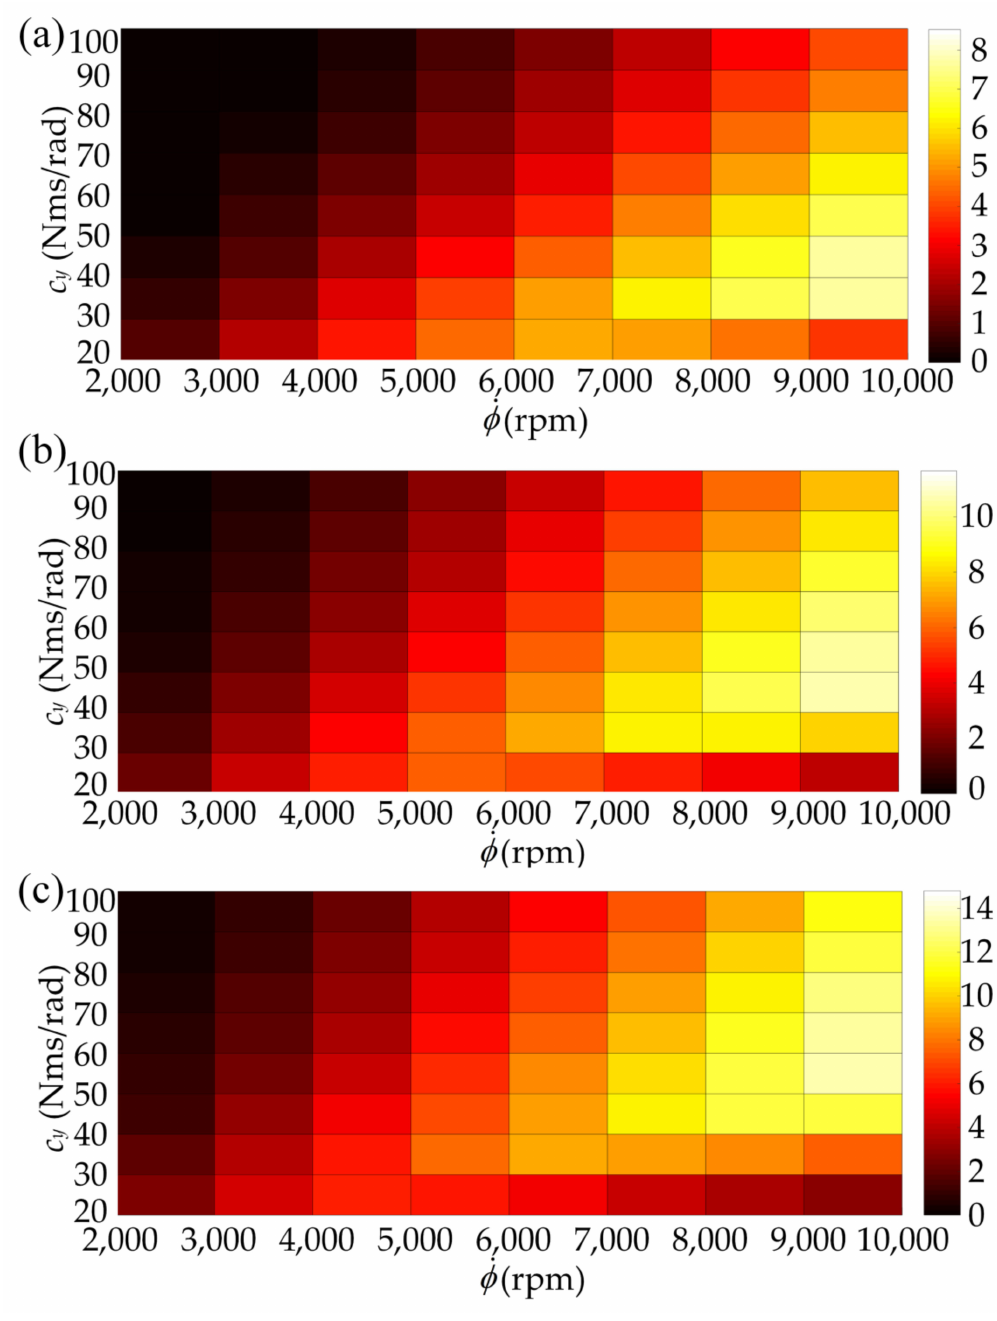
Figure 5. Hot colormap array of power output with different wave amplitudes under rated conditions: ( a ) A = 8 ◦ ; ( b ) A = 10 ◦ ; ( c ) A = 12 ◦